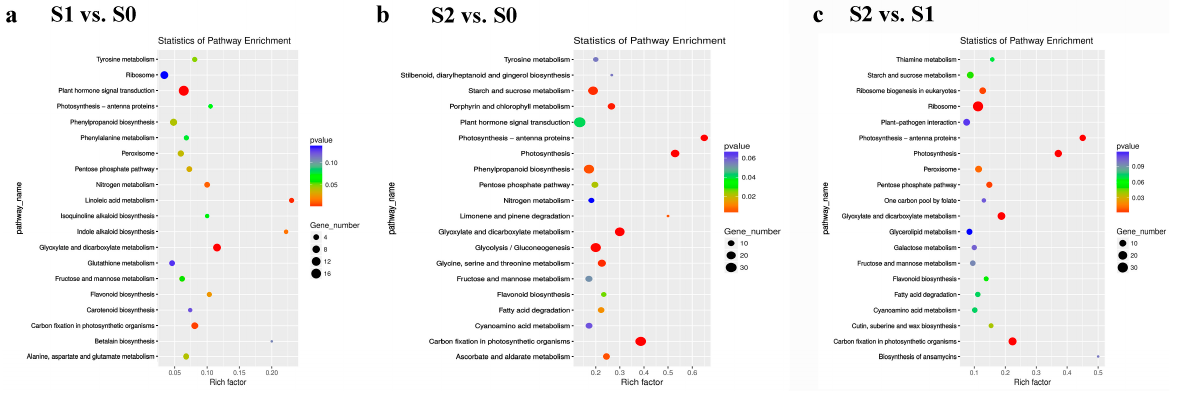
Figure 3. KEGG enrichment analysis for all three comparisons. ( a ) KEGG enrichment analysis for S1 vs. S0; ( b ) KEGG enrichment analysis for S2 vs. S0; ( c ) KEGG enrichment analysis for S2 vs. S1.